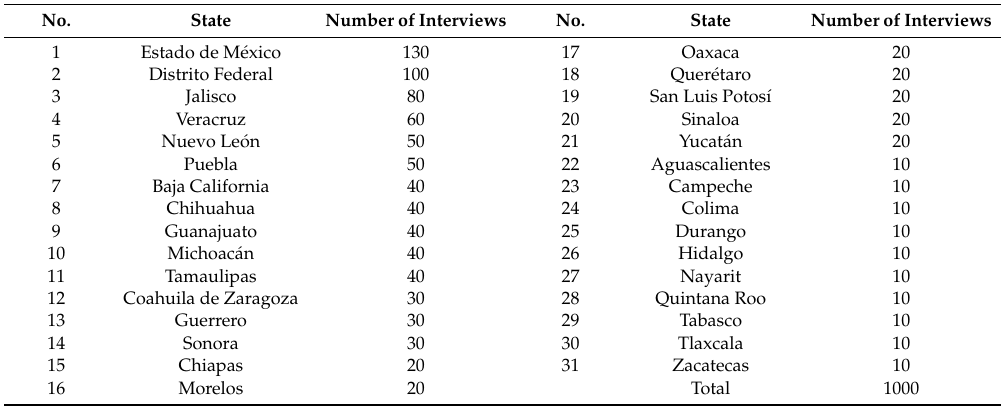
Table 5. The number of interviews for each Mexican state.